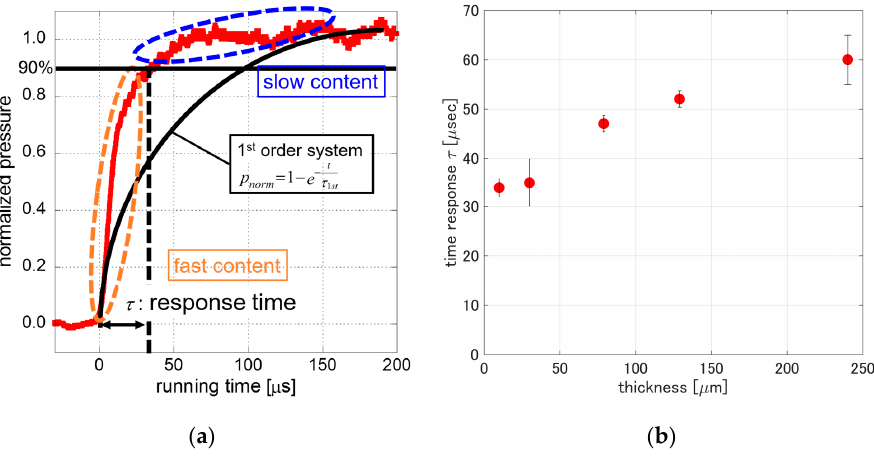
Figure 8. ( a ) Step response of PCPSP th 01 following a normal shock wave; ( b ) Response time related to PC-PSP thickness.